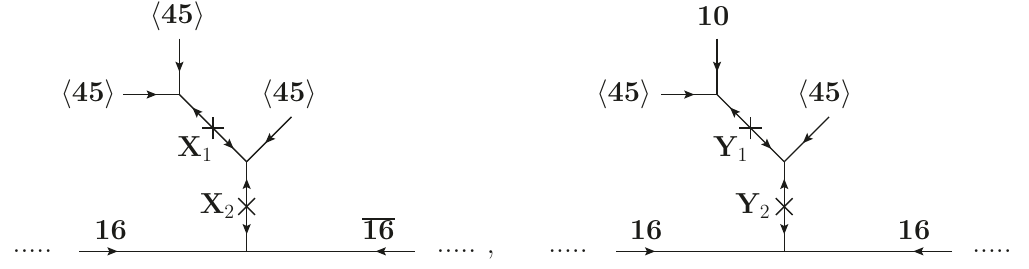
written using renormalizable interaction terms with mediators of the type 16 and 16 . The mass insertions are labelled by a (cid:2) . The angle brackets denote the SM singlet GUT-scale VEVs of the scalar component of the 45 s, such that the diagram forms a Yukawa term. Neighboring VEV insertions commute among each other, but not with the insertion of the EW scale VEV of the Higgs (cid:12)eld representation. Thus, it is crucial whether a h 45 i is located on the left- or right-hand side of the 10